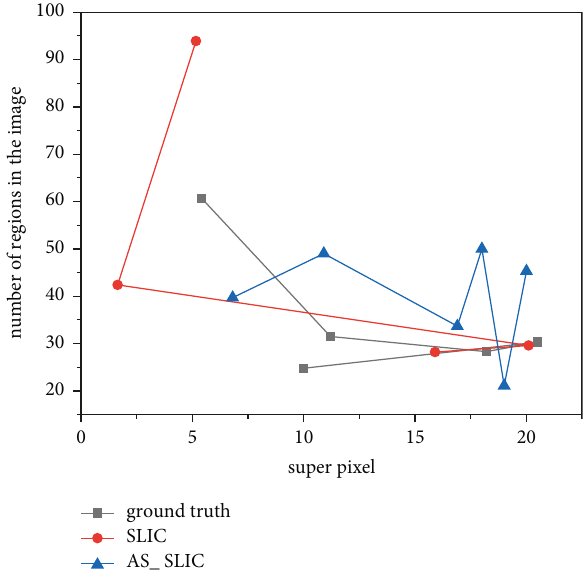
Figure 5: Comparison of the number of superpixels generated by the